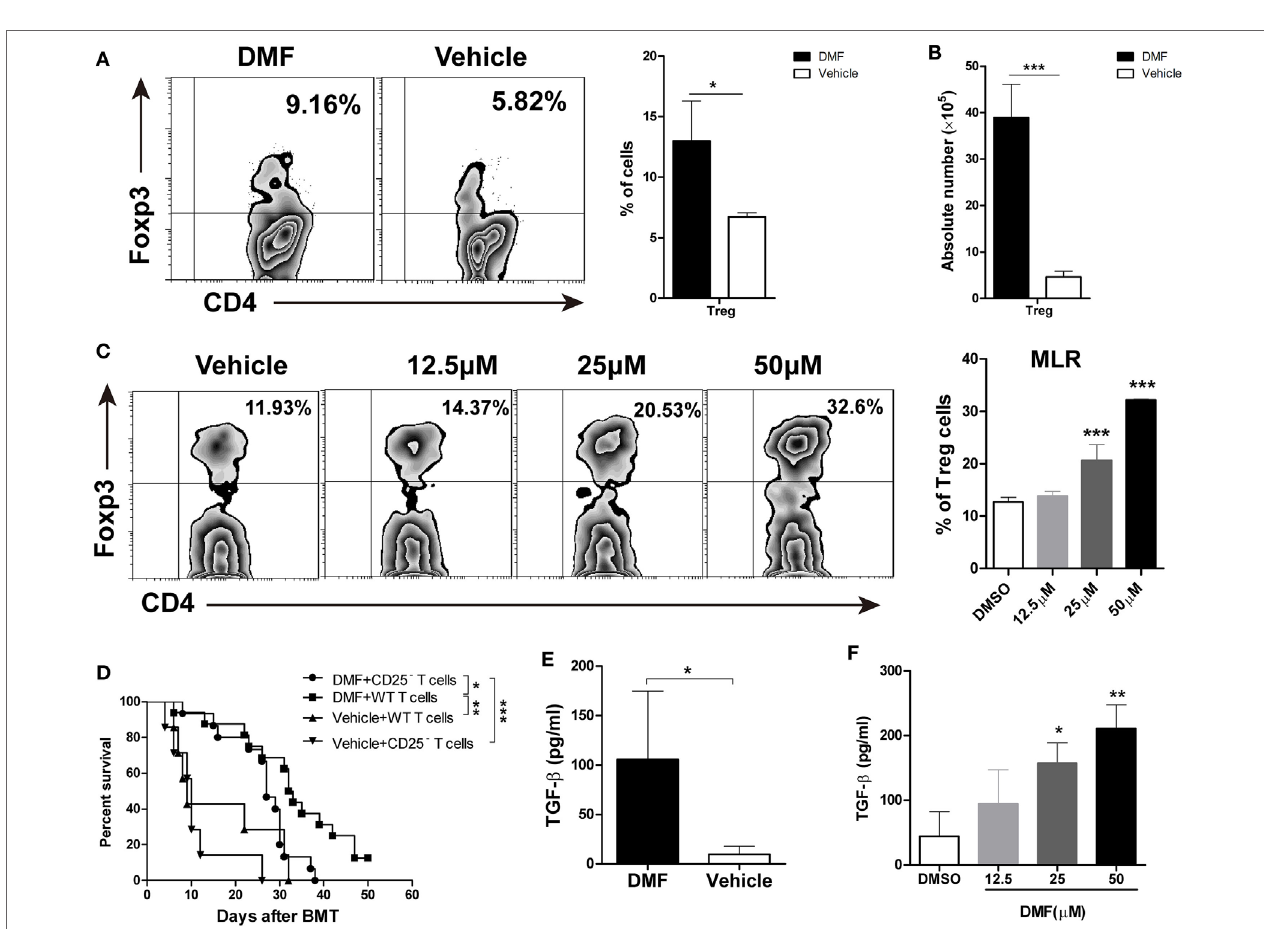
FigUre 4 | Dimethyl fumarate (DMF) inhibits acute graft-versus-host disease (aGVHD) by promoting Treg cells in vitro and in vivo. The frequencies and absolute number of CD4 + Foxp3 + Treg cells in spleen on day 14 after bone marrow transplantation (BMT) were examined by FACS (a,B) . Purified CD4 + T were activated by anti-CD3/CD28 in the presence of TGF- β (2 ng/ml) and IL-2 (50 U/ml) to induce Treg cells development in vitro , The effect of DMF on Treg cells differentiation was measured by FACS 4 days after Treg polarization (c) . Lethally irradiated BALB/c mice were transplanted with 5 × 10 6 TCD-BM plus 1 × 10 6 total spleen T cells or CD25-depleted T cells from B6 mice. Depletion of CD25 + cells in DMF recipients aggravated aGVHD mortality compared with IgG control recipients (D) . TGF- β levels in serum of aGVHD mice and MLR culture supernatants were measured by qRT-PCR (e,F) . Survival data were analyzed by log-rank test and Kaplan-Meier survival curves were generated using GraphPad Prism. Data shown are mean ± SD. * P < 0.05; ** P < 0.01; *** P < 0.001, compared with DMSO group or vehicle group (Student’s t -test), or DMSO group (ANOVA with Dunnett’s test).